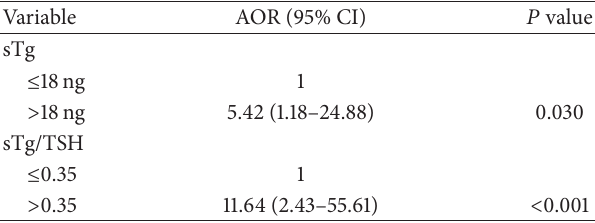
Table 4: Multivariate analysis of sTg levels, sTg/TSH ratio, and unsuccessful